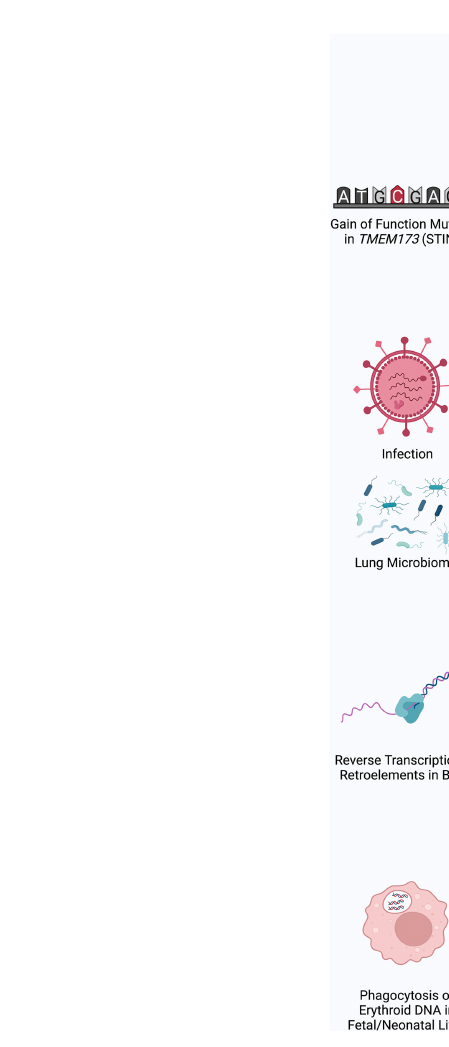
FIGURE 3 | SAVI is due to gain-of-function in STING that is highly expressed in the lung and endothelium, possibly as a means of viral defense. COPA Syndrome disease activity depends on input of DNA, which may come from tonic microbiota signaling in the lung and is worsened in the setting of infection. Failed recycling of activated STING due to pathogenic COPA variants results in excess STING signaling. AGS is due to accumulation of nucleic acids in the brain due to failed degradation of DNA made from reverse transcribed retroelements. This DNA burden then increases STING signaling. DNAseII de fi ciency initially presents with severe anemia and liver dysfunction due to in fl ammation from failed ability of macrophages to digest RBC nuclei in the lysosome where DNAseII operates. Similar to AGS, failed clearance of DNA results in increased STING signaling. Created with